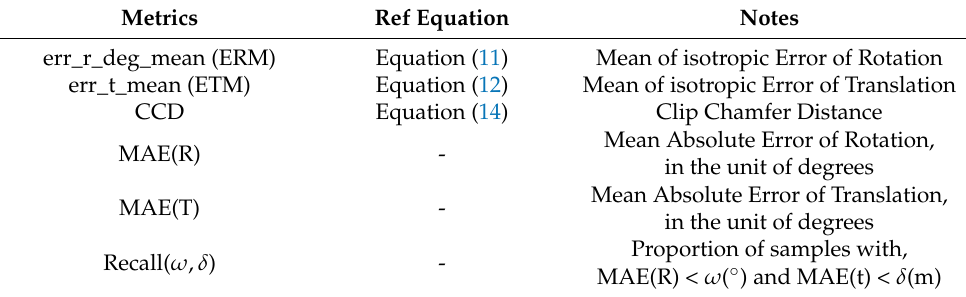
Table 2. Evaluate Metrics.